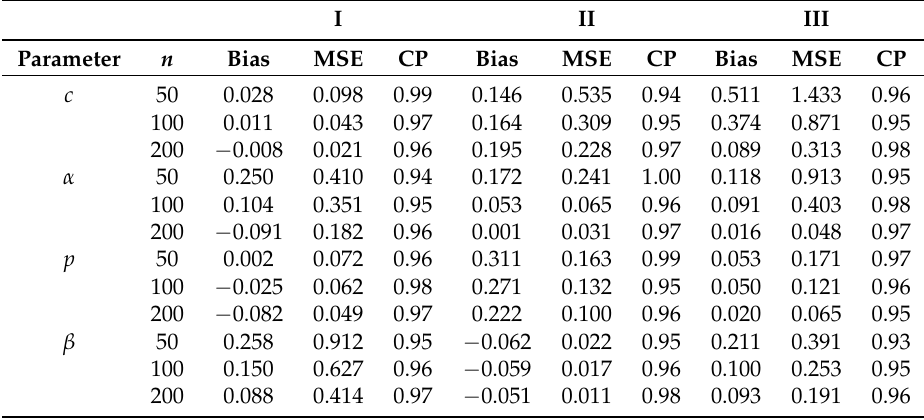
Table 2. Biases, MSEs and CPs of the simulation